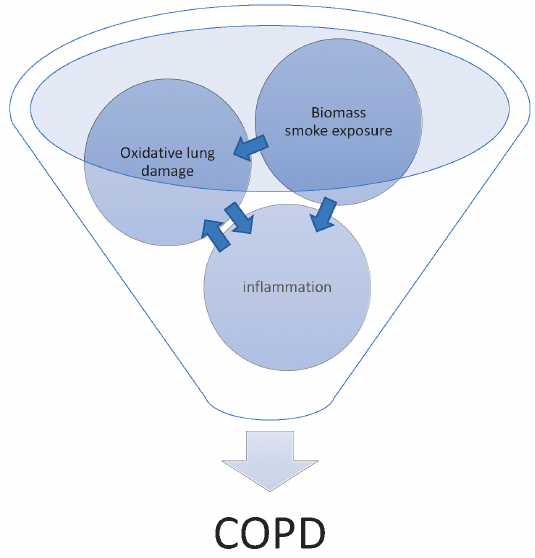
Figure 1. Graphical representation of the interaction of biomass smoke, oxidative lung damage and inflammation in the initiation of chronic obstructive pulmonary disease (COPD). inflammation in the initiation of chronic obstructive pulmonary disease